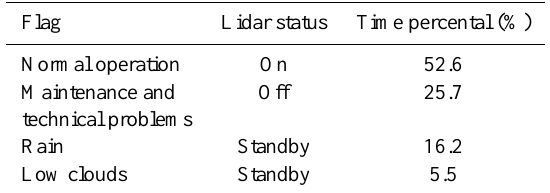
Table 1. Yearly time percental of the different flags allocated by the system for the period 1 October 2009 to 30 September 2010. Flag Lidar status Time percental (%) Normal operation On 52.6 Maintenance and Off 25.7 technical problems Rain Standby 16.2 Low clouds Standby 5.5